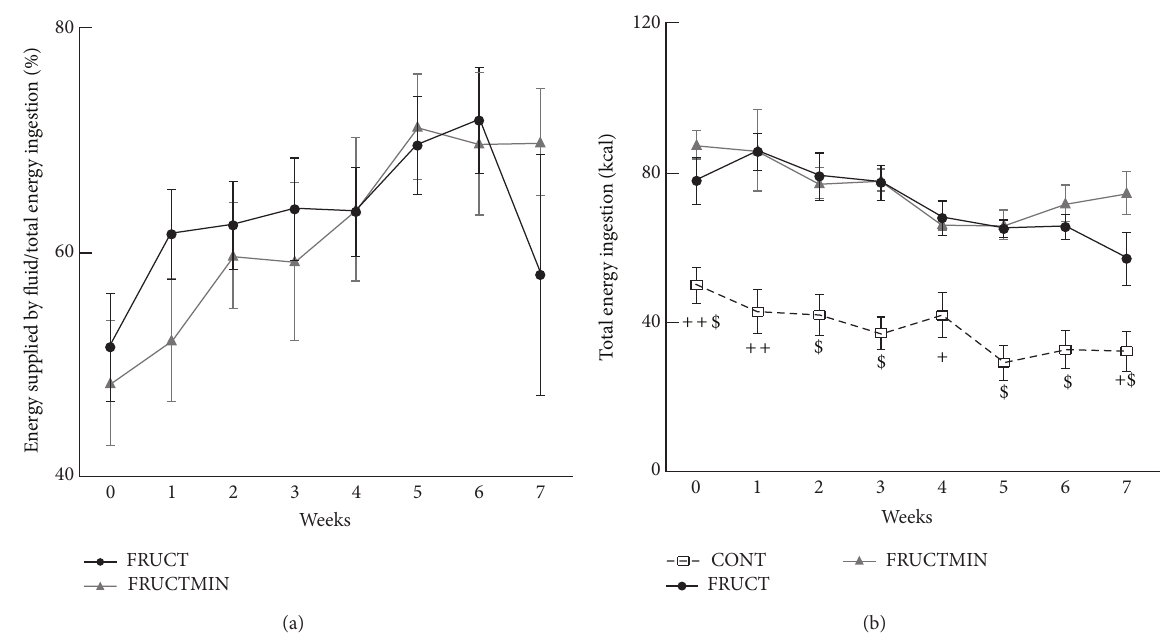
Figure 2: (a) Percentage energy supplied by fluid/total energy ingestion ( 𝑛 = 7 ) and (b) total energy ingestion evolution (kcal; 𝑛 = 7 ; + 𝑃 < 0.05 CONT versus FRUCT and FRUCTMIN; ++ 𝑃 < 0.01 CONT versus FRUCT and FRUCTMIN; $ 𝑃 < 0.001 CONT versus FRUCT and FRUCTMIN; +$ 𝑃 < 0.05 CONT versus FRUCT and 𝑃 < 0.001 CONT versus FRUCTMIN; ++$ 𝑃 < 0.01 CONT versus FRUCT and 𝑃 < 0.001 CONT versus FRUCTMIN), during the dietary intervention. Results were expressed as mean ± standard error of the mean. CONT: control; FRUCT: 10% fructose in tap water; FRUCTMIN: 10% fructose in natural mineral-rich